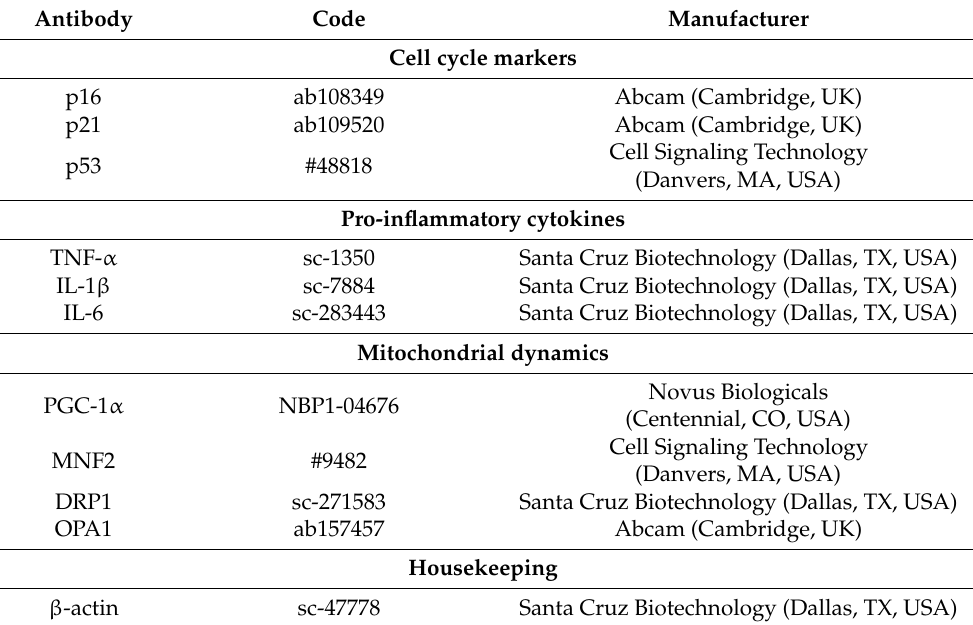
Table 1. Primary antibodies for Western blot